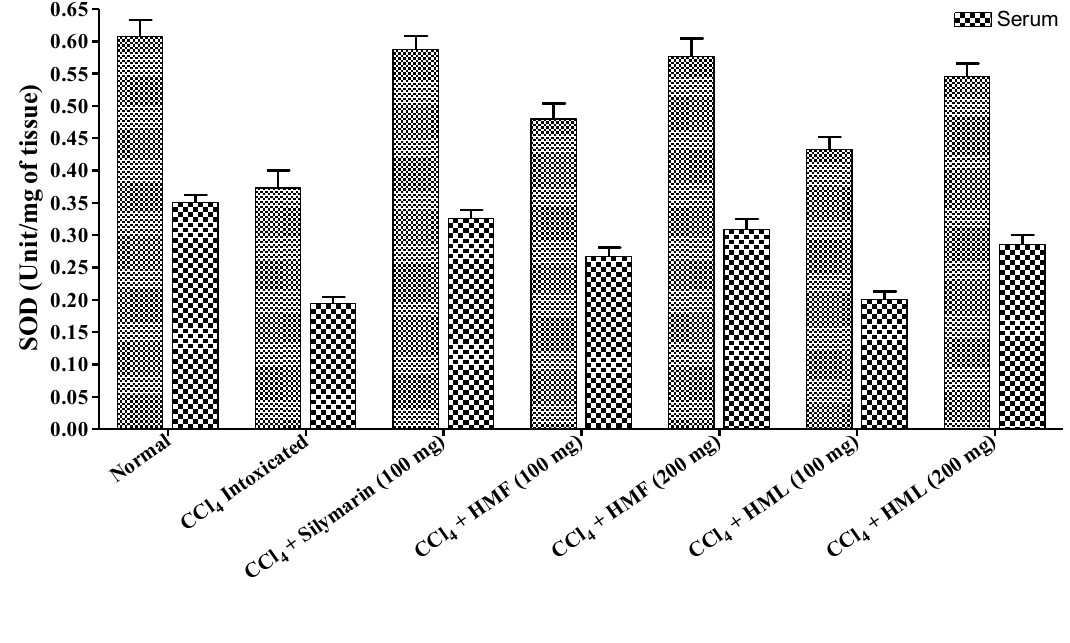
Figure 2. The effect of HMF and HML on SOD enzyme levels in liver and